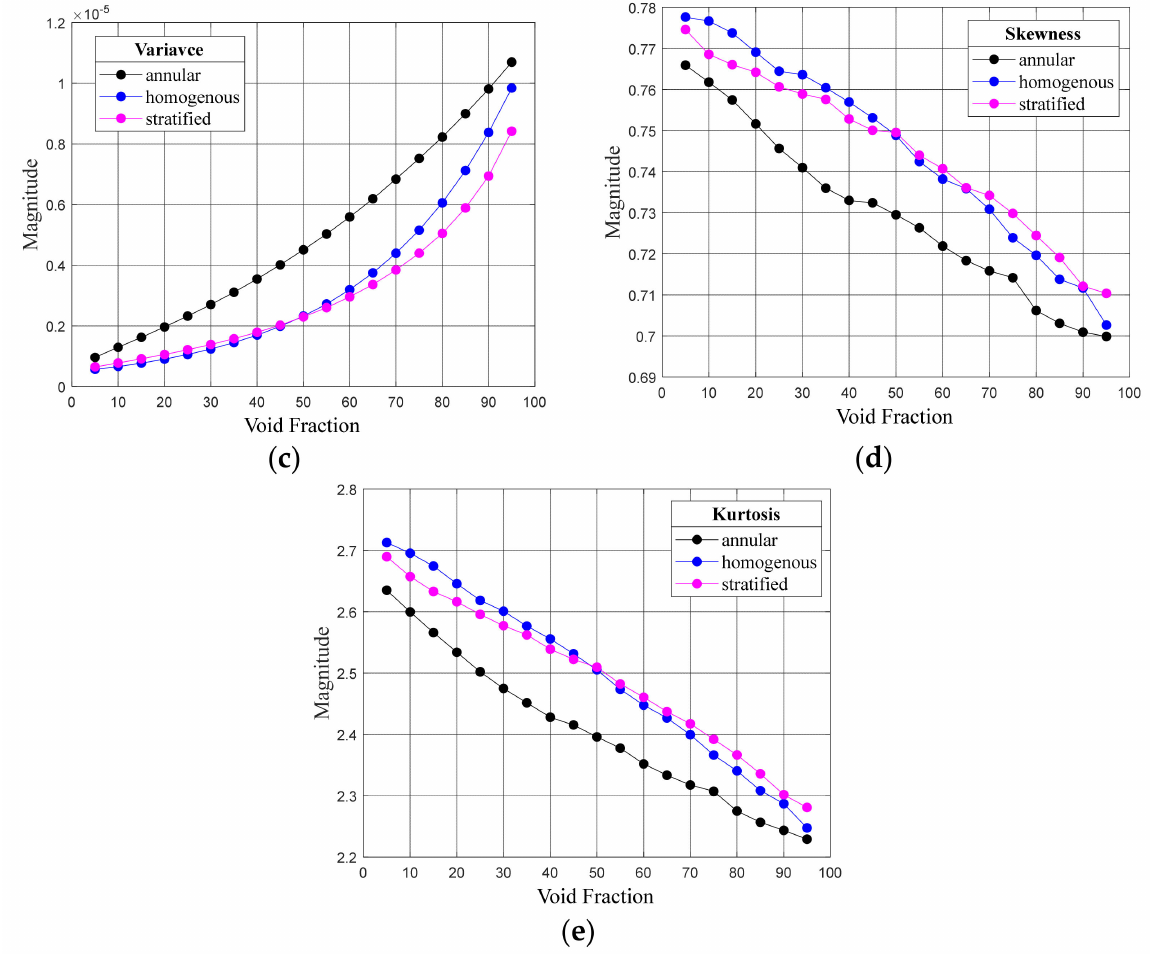
Figure 6. Extracted characteristics: ( a ) SVER, ( b ) SSR, ( c ) variance, ( d ) skewness, ( e )